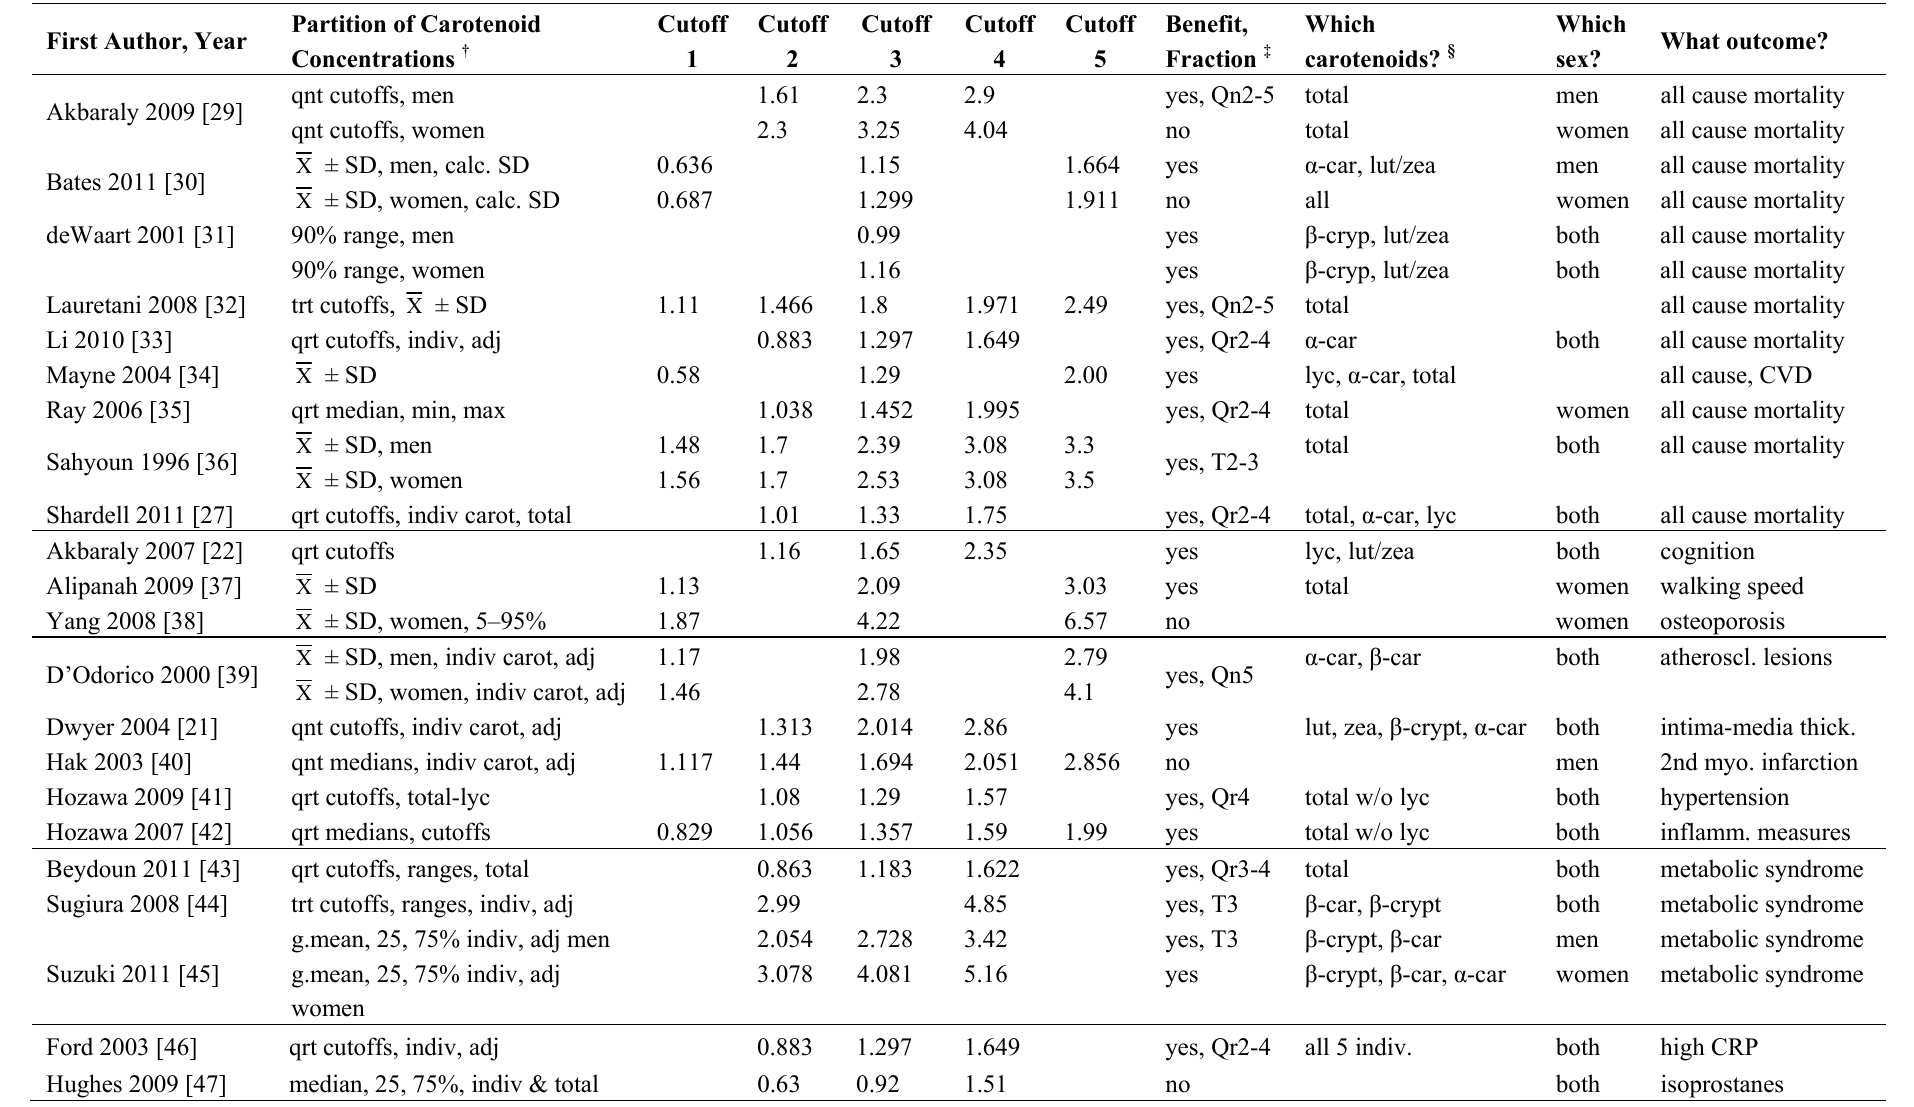
Table 3. Summary Data for the Carotenoid Health